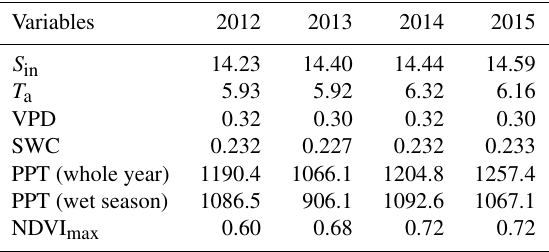
Table 1. The average value of daily solar radiation ( S in , MJm − 2 d − 1 ) , the mean annual air temperature ( T a , ◦ C), the mean annual vapour pressure deficit (VPD,kPa), the mean annual soil wa- ter content (SWC,m 3 m − 3 ) , the total amount of precipitation (PPT, mm) for the whole year and the wet season, and the maximum value of NDVI for each year from 2011 to 2015.